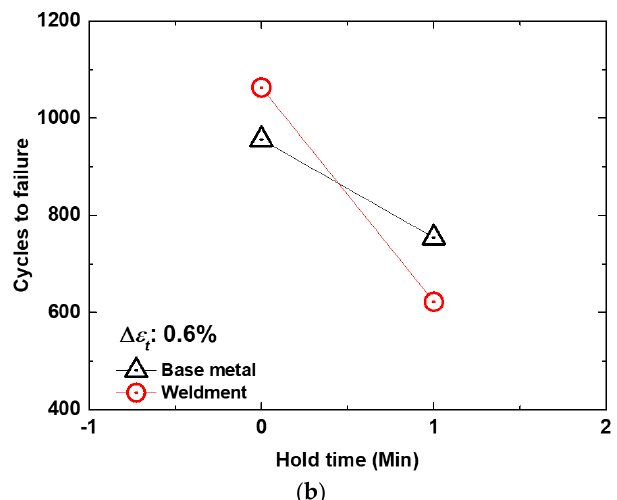
Figure 4. ( a ) LCF life graphs as a function of total strain range; ( b ) influence of hold ‐ time (HT) on LCF life of Alloy 800H BM and weldments.